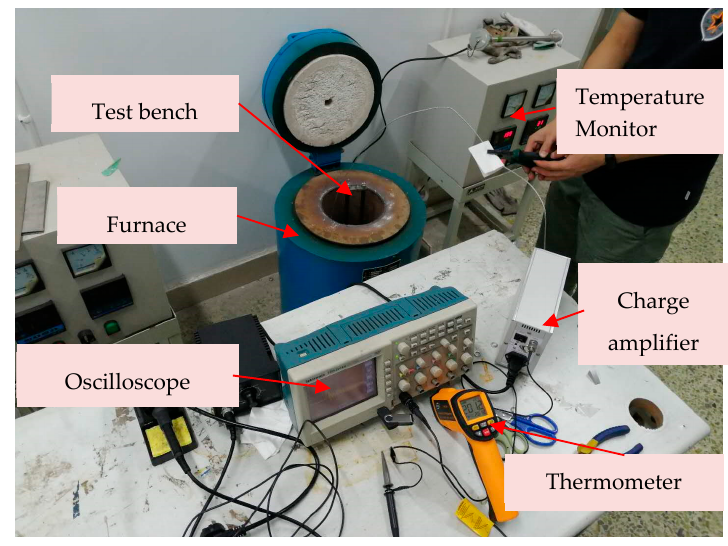
Figure 4. The schematic diagram of the drop test system under 260 °C condition.